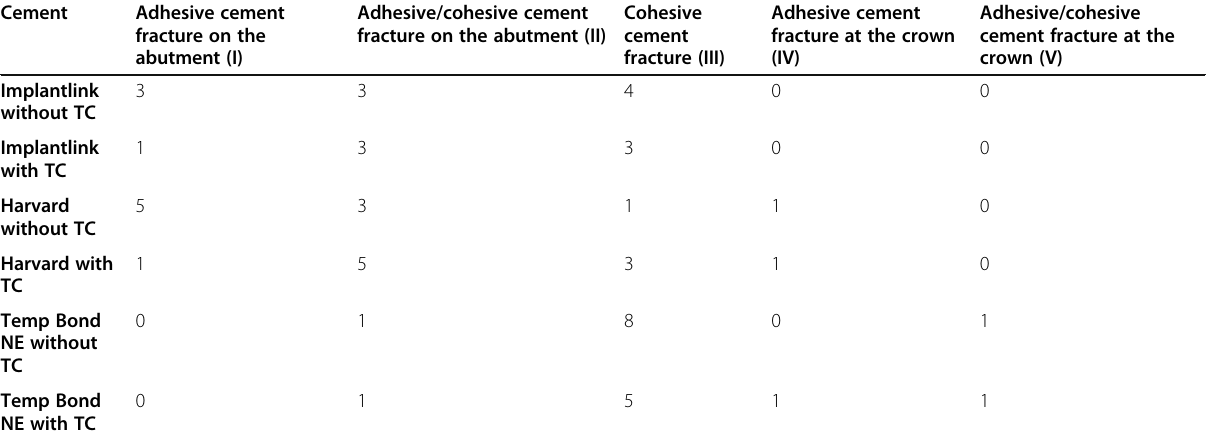
Table 3 Number of specimens regarding the fracture mode for each temporary cement Cement